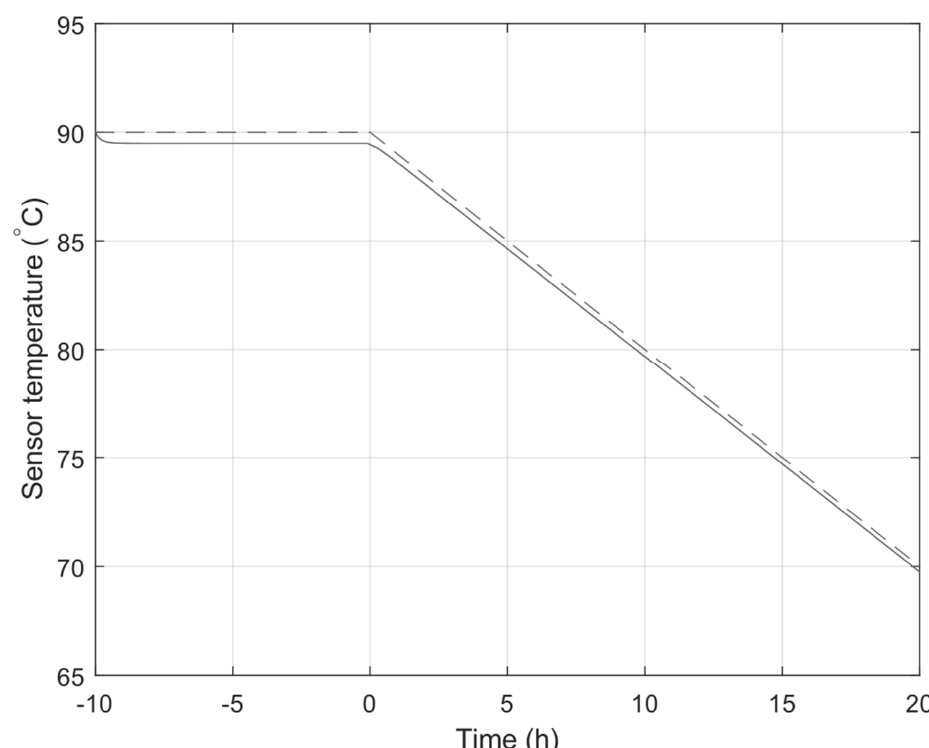
Figure 8. The modelled sensor temperature (solid line) as a function of the time after the change in the supply pipe temperature. The dashed line shows the supply pipe temperature, with a temperature drop starting at time zero (the first hour is slow due to the thermal response time). The initial temperature in the drainage valve pipe is 90 ◦ C at t = − 10 h. At time zero the supply temperature starts dropping from 90 ◦ C at 1 ◦ C /h.